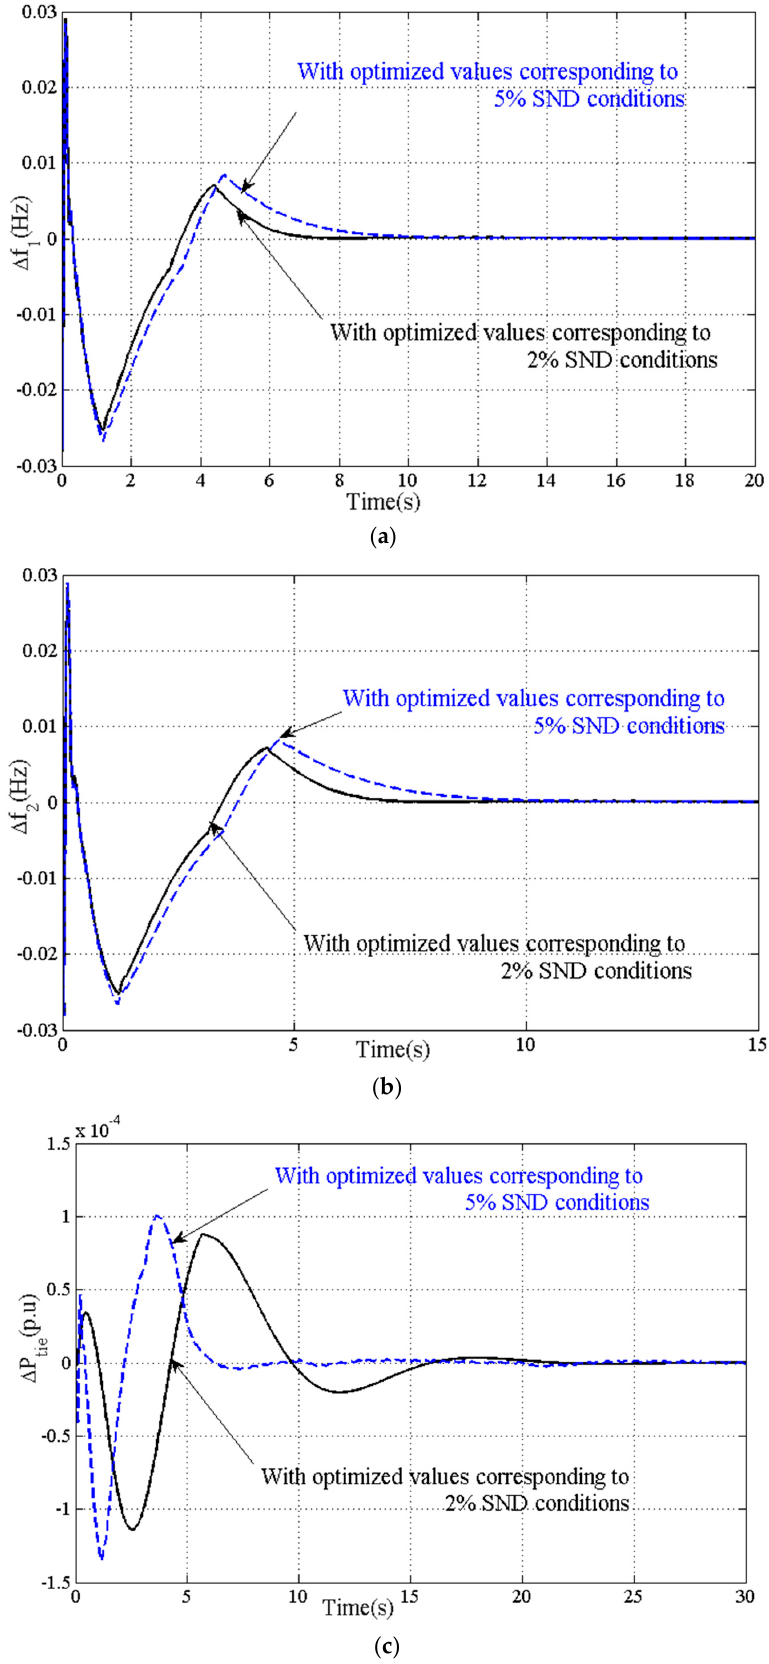
Figure 15. Insensitiveness of PID controller at 5% SND. ( a ) ∆ f 1 ; ( b ) ∆ f 2 ; and ( c ) ∆ P tie . In Figures 14 and 15, it is seen that the responses with the nominal and obtained parameters are not deviating too much, i.e., they are almost the same, which proves the insensitiveness (robustness) of the optimal PID parameters obtained at the nominal SND (2%) for wide variations in SND (3% and 5%). 5.4.2. With Changed Time Constants of WTs In this study, the time constant ( T WT = 1.5 s) of intermi tt ent WTs is changed by ±25%, i.e., to 1.125 s and 1.875 s, and, again, the PID parameters are tuned with the SAO algo- rithm, separately, for 1.125 s and 1.875 s and are shown in Table 6. In these changed con- ditions, i.e., T WT = 1.125 s and T WT = 1.875 s, the dynamics are compared with the nominal WT time constant value ( T WT = 1.5 s) using the gains given in Table 1 and are shown in Figures 16 and 17.